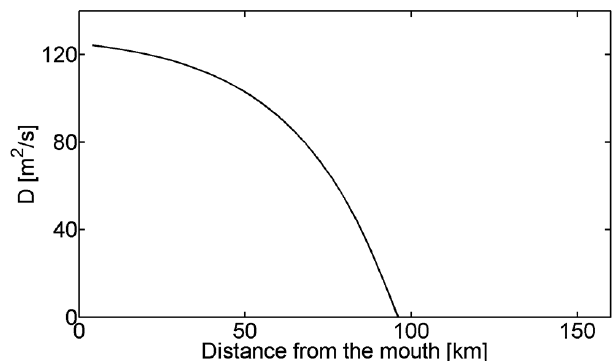
Figure 7. Longitudinal dispersion coefficient distribution modeled using a constant freshwater discharge Q = 39m 3 s − 1 and a Van der Burgh coefficient K of 0.39.